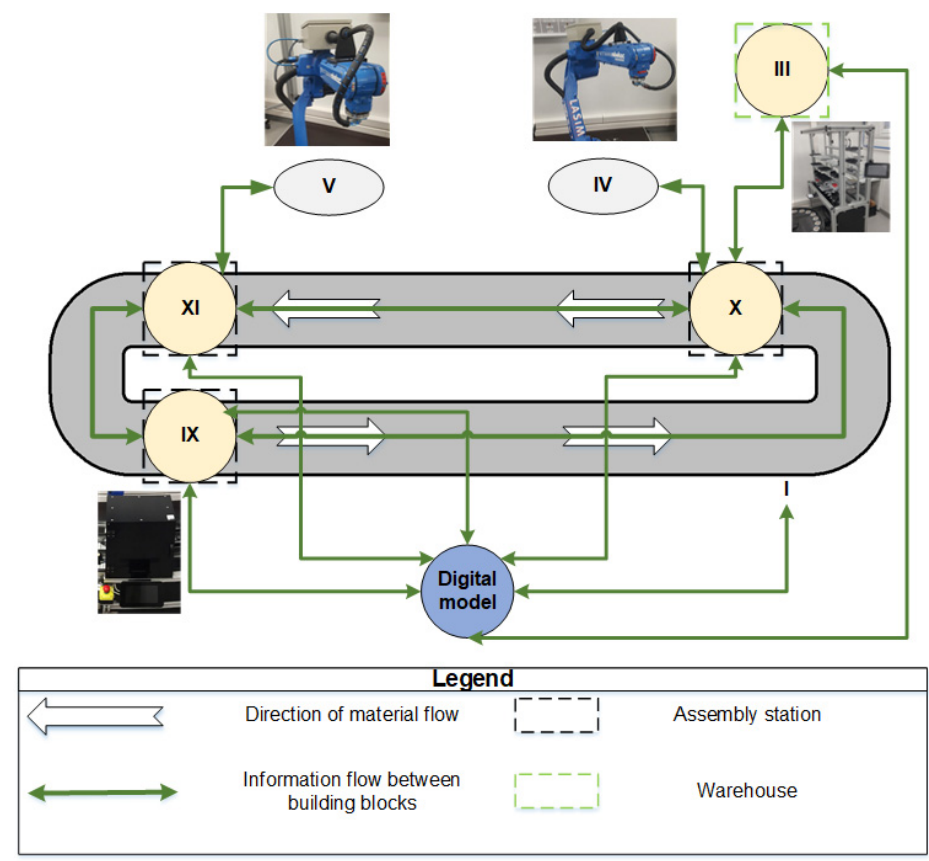
Figure 15. Connections between the digital model and the six main building blocks in the case